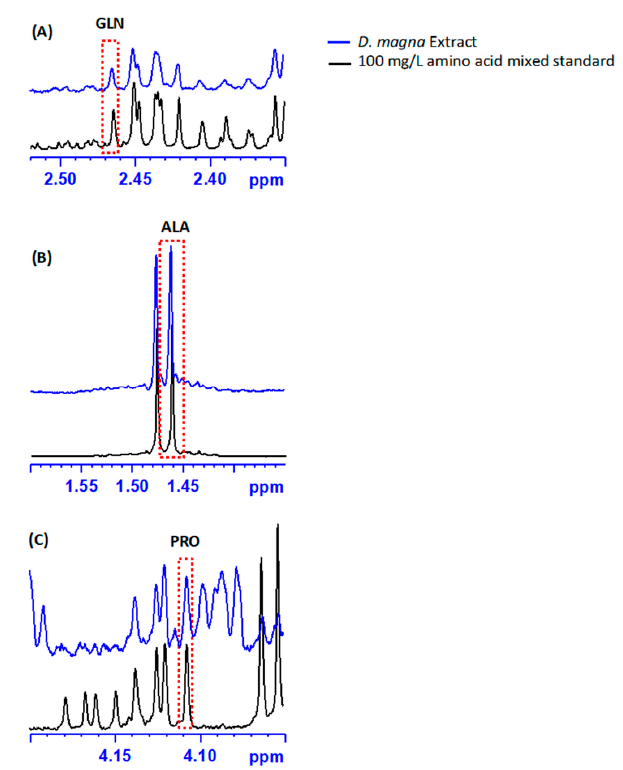
Figure 3. A comparison of the 1 H NMR spectra of a D. magna extract and a mixed amino acid standard (100 μ g/L), both in D 2 O buffer, highlighting the regions used for the quantification of ( A ) glutamine (GLN), ( B ) alanine (ALA), and ( C ) proline (PRO). A red dotted box indicates the specific resonance used for quantification for each amino acid.